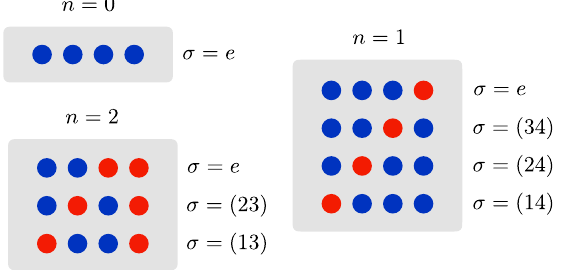
FIG. 2. All possible clusterings of N ¼ 4 systems when each can be in one of two possible states, depicted as blue and red. The pair of indices ð n; σ Þ identifies each clustering, where n is the size of the smallest cluster and σ is a permutation of the reference clusterings (those on top of each box), wherein the smallest cluster falls on the right. The symbol e denotes the identity permutation, and ð ij Þ the transposition of systems in positions i and j . Note that the choice of σ is not